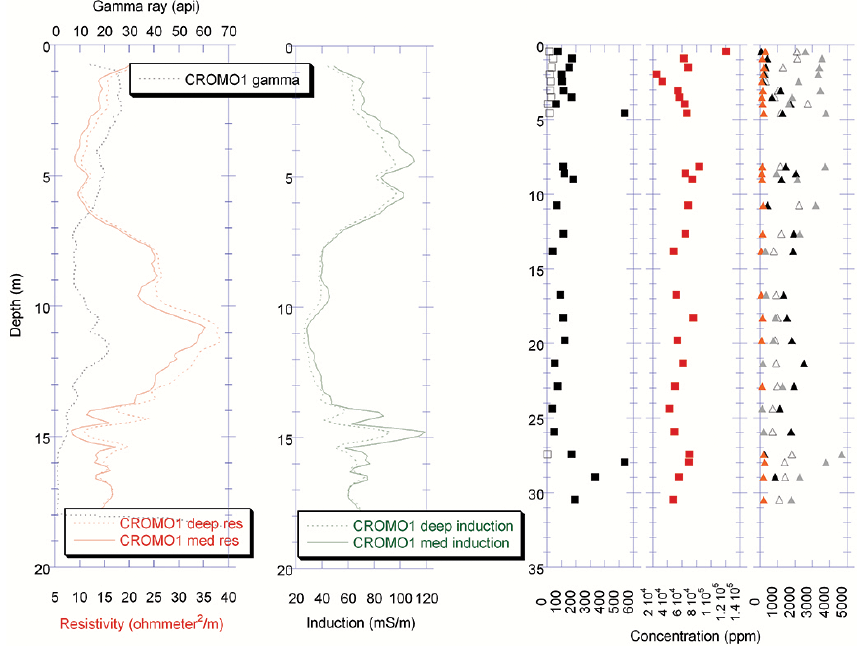
Figure 3. Geophysical logging results (temperature, gamma, induction, resistivity logs) for CROMO1, drilled near the Homestake Mining Inc. Core Shed at the McLaughlin Natural Reserve. In all plots, depth is plotted along the y axis, as meters below surface. Leftmost panel: this depth profile shows variation in gamma ray signal in units of api; U, Th, K-concentrating lithologic units drive values up. Also shown are observed resistivity data in units of Ω m 2 m − 1 ; medium resistivity conveys information about resistivity near tool, while deep resistivity conveys information about resistivity far from tool in the surrounding formation. Left-middle panel: this depth profile shows observed induction in units of mSiemensm − 1 , a measure of induced electrical field in formation rocks; medium induction conveys information about conductivity near tool, while deep induction conveys information about conductivity far from tool. Right trio of panels: bulk powder XRF geochemical data for selected analytes (Sr, Rb, Fe, Mn, Cr, V, Ti) are shown in a trio of plots; Sr data are filled squares, Rb data are open squares, Fe data are red squares, Mn data are open triangles, Cr data are black triangles, V data are brown triangles, and Ti data are gray